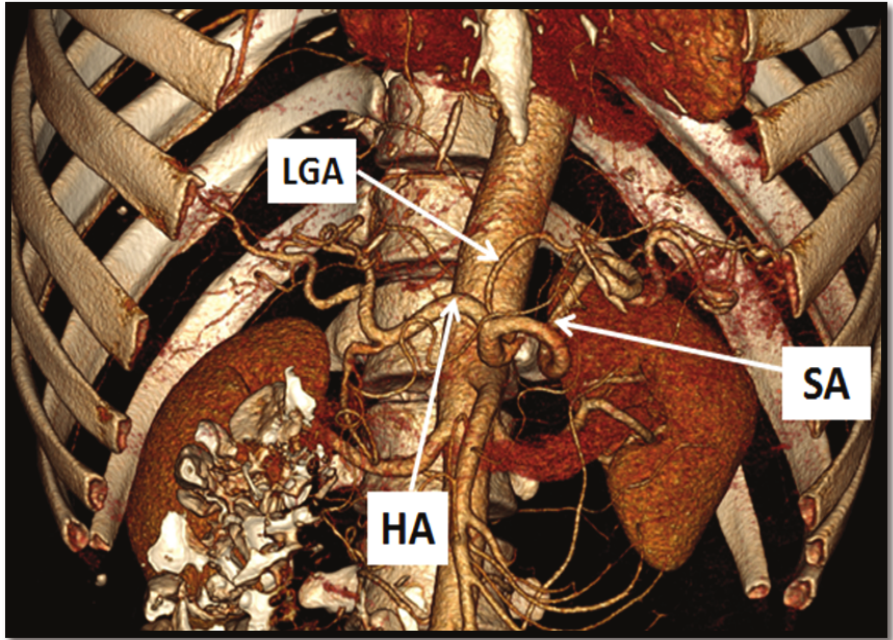
Figure 3 : CT angiography of Toshiba Aquilion 𝑇𝑀 64 slice (Toshiba Medical Systems, Nasu, Japan) showing Michel type I, the celiac trunk dividing into three branches – left gastric artery (LGA), common hepatic artery (CHA), and splenic artery (SA).